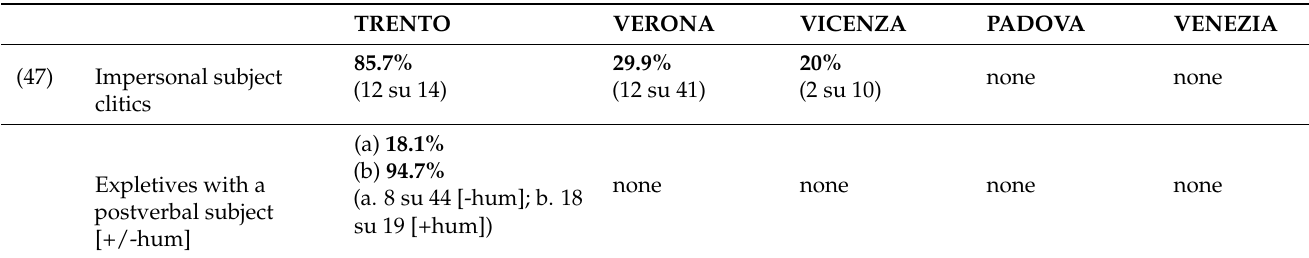
Table 2. Rate of expletive